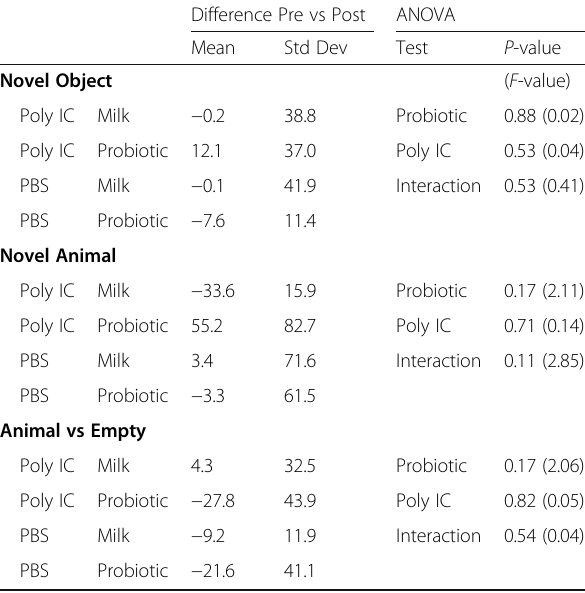
Table 3 Behavioral changes by probiotic intervention among four different experiment